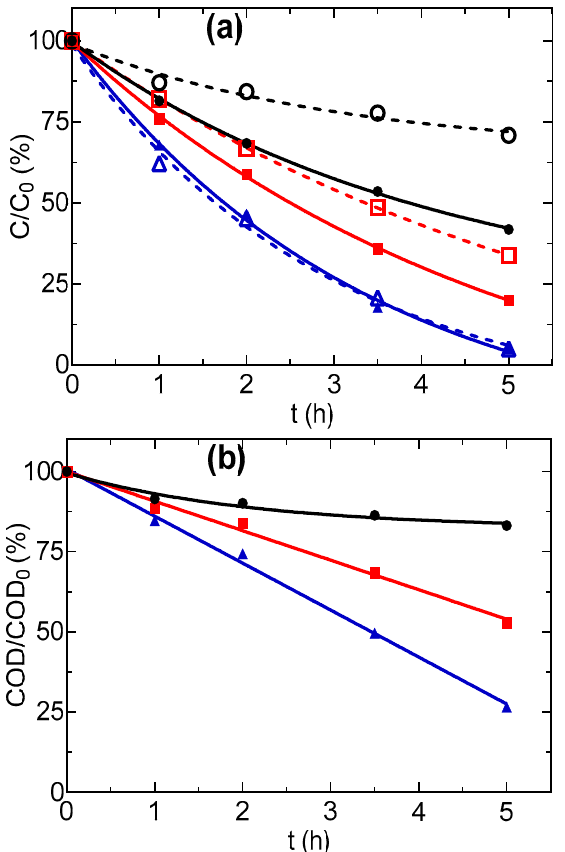
Figure 8. Decay of normalized ( a ) concentration, ( ○ , □ , ∆ ) TW80 and ( ● , ■ , ▲ ) phenanthrene, and ( b ) COD during the AO of 330 mL SW solution at applied current of ( ○ , ● ) 200 mA, ( □ , ■ ) 500 mA, and ( ∆ , ▲ ) 1000 mA. Reprinted with the permission of [16].